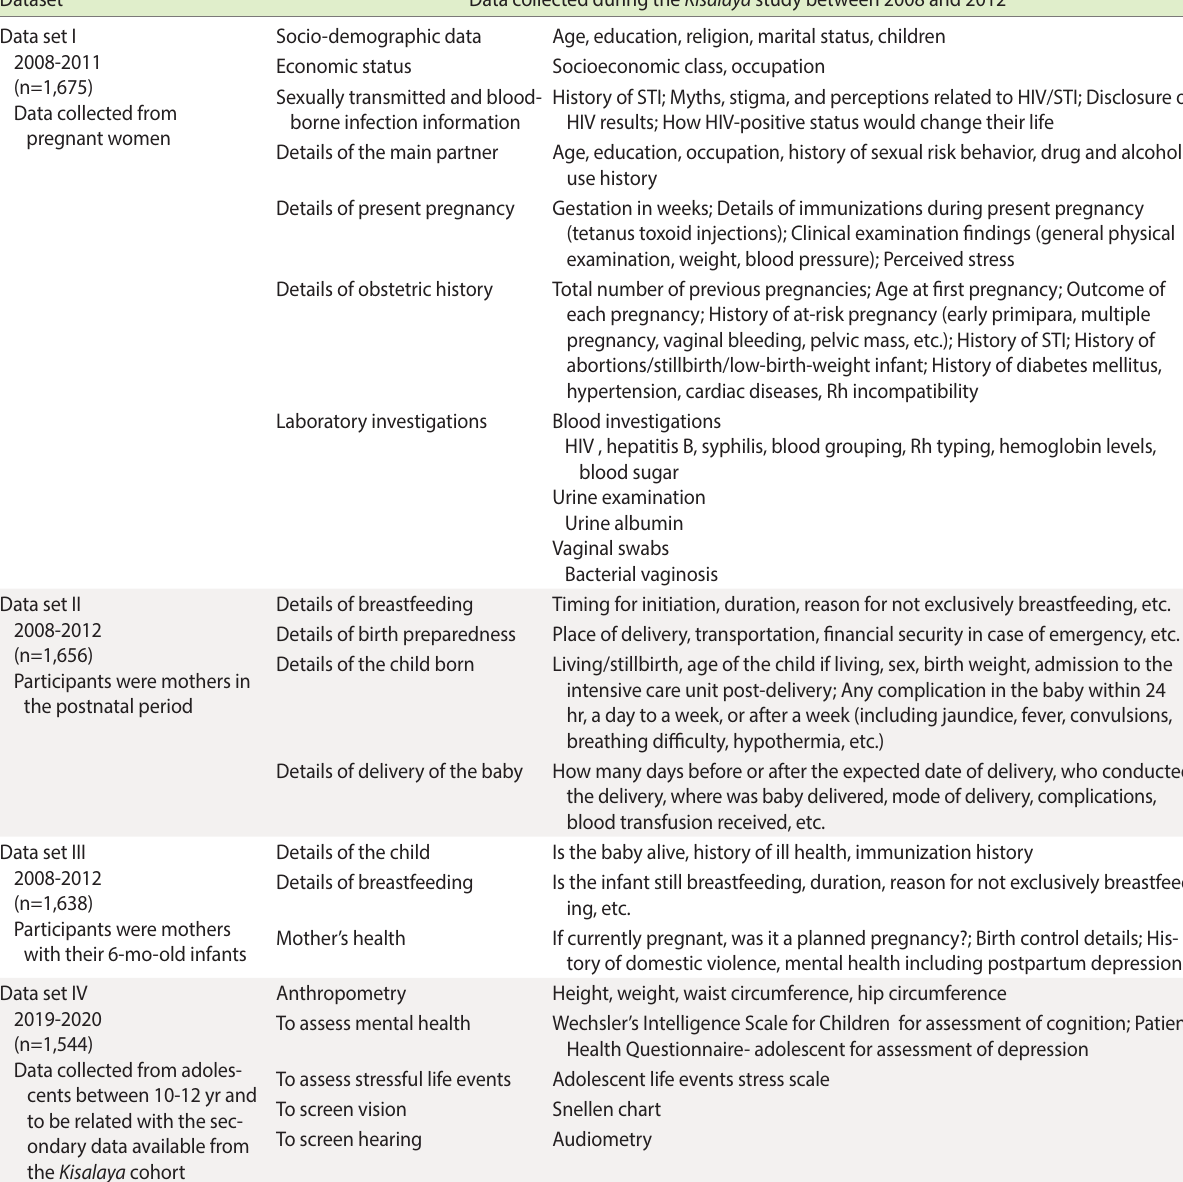
Table 1. Details of the data collected and to be collected in the follow-up study of the Kisalaya cohort (2008-2012) Dataset Data collected during the Kisalaya study between 2008 and